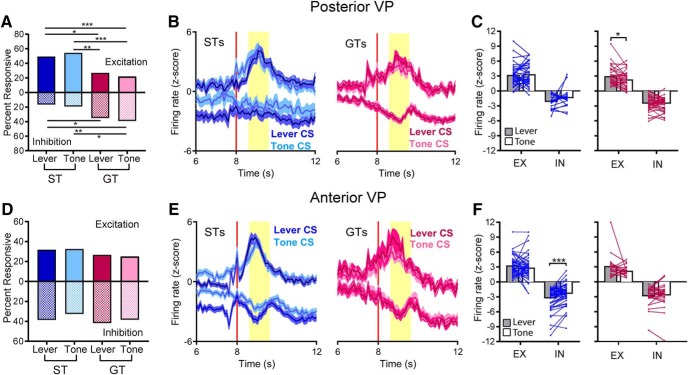
Many VP cells were responsive to presentation of the food reward (i.e., the US) in both the posterior VP (top row) and the anterior VP (bottom row). A, Although there were no differences between lever-CS trials and tone-CS trials in the posterior VP, STs had a higher proportion of excitatory responses than GTs, and GTs had a higher proportion of inhibitory responses than STs (*, p < 0.05; **, p < 0.01; ***, p < 0.001). B, Responses to the US were prominent during a 1-s period when the food pellet was delivered, which occurred 0.6–1.6 s after the CS phase ended and pellet was released from the food dispenser (shown as time = 8 s). C, In STs (left) there were no significant differences in the magnitude of firing in lever-CS versus tone-CS trials, although GTs (right) showed significantly higher firing rates in lever-CS trials than tone-CS trials (*, p < 0.05; gray and white bars represent mean firing rate; EX, excitation; IN, inhibition). D, In the anterior VP, there were no significant differences in the proportion of cells responsive to the US. E, F, STs (left) had significantly lower firing rates in lever-CS trials than tone-CS trials (***, p < 0.001), whereas GTs (right) showed no differences in firing during lever-CS versus tone-CS trials.